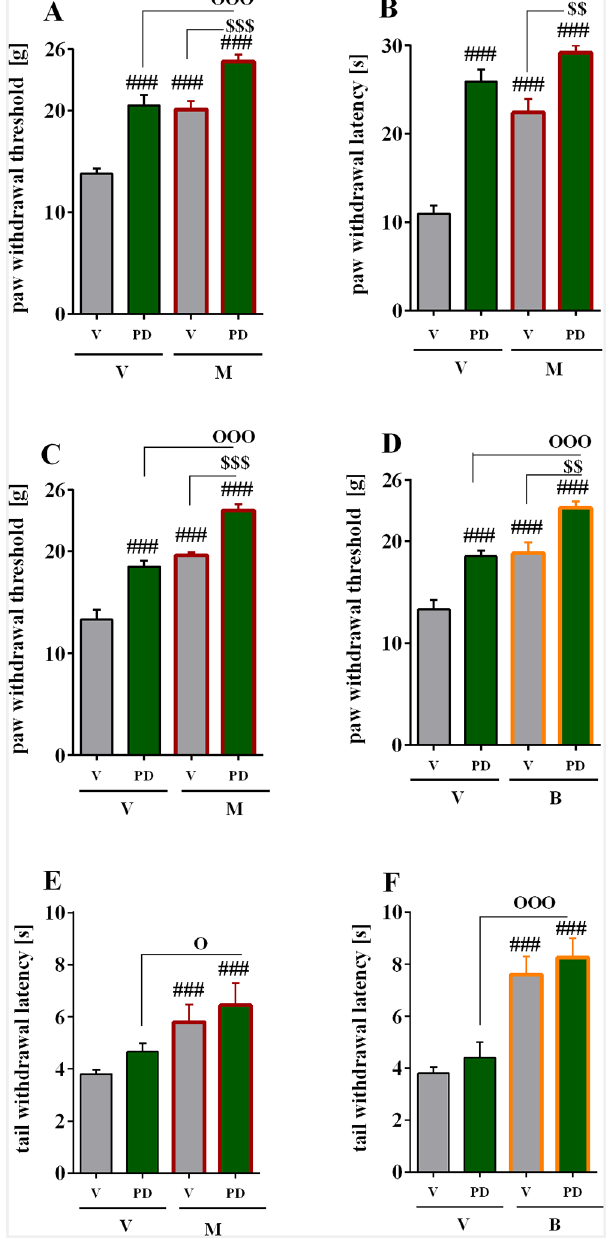
Fig 4. Effect of PD98059 on opioid analgesia in a naive and neuropathic rats. Effect of repeated vehicle or PD98059 administration (2.5 mcg/5 mcl; i . t .; 16 h and 1 h before CCI and then once daily for 7 days) on the analgesic effects of a single injection of morphine (5 mcg/5 mcl; i . t .) in CCI-exposed rats on day 7 after injury as measured by von Frey (A) and cold plate (B) in neuropathic animals. Effect of a single administration of vehicle or PD98059 (2.5 mcg/5 mcl) on a single i . t . injection of morphine (C, 2.5 mcg/5 mcl) and buprenorphine (D, 2.5 mcg/5 mcl) as measured by von Frey in neuropathic animals. Effect of a single administration of vehicle or PD98059 (2.5 mcg/5 mcl) on a single i . t . injection of morphine (E, 0.5 mcg/5 mcl) and buprenorphine (F, 2.5 mcg/5 mcl) as measured by tail flick test in naive animals. Behavioral tests were conducted 30 min after vehicle or PD98059 administration and then 30 min after a single vehicle, morphine or buprenorphine injection. Data are presented as the means ± SEM. The inter-group differences were analyzed using ANOVA and Bonferroni ’ s multiple comparison test. ### p < 0.001 indicates a significant difference compared to the control group; $$ p < 0.01 and $$$ p < 0.001 indicate significant differences compared to the repeated or single PD-treated CCI-exposed rats which received single morphine or buprenorphine